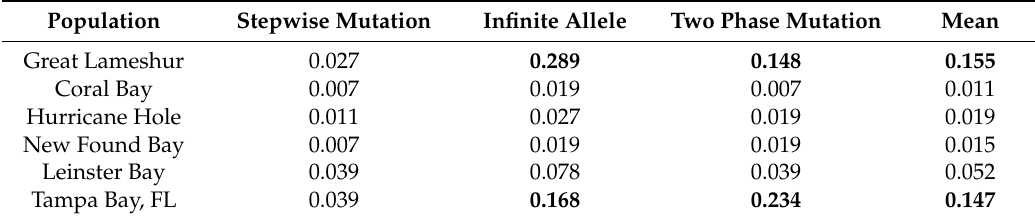
Table 2. Bottlenecks analysis performed using three models of evolutionary change. The probability of population bottlenecks was determined using the one-tailed Wilcoxon test with the three models applied. Values supporting bottlenecks are in Bold .